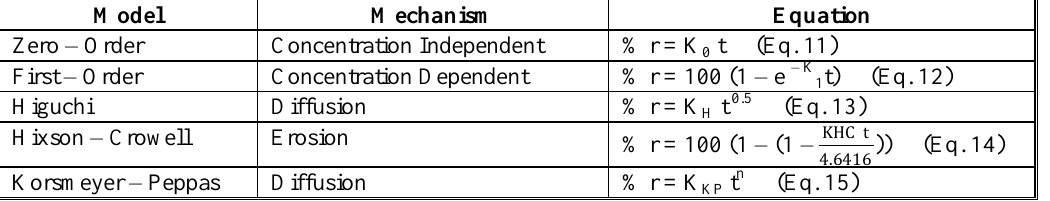
Table 2: Mathematical models and dissolution mechanisms describing release kinetics.